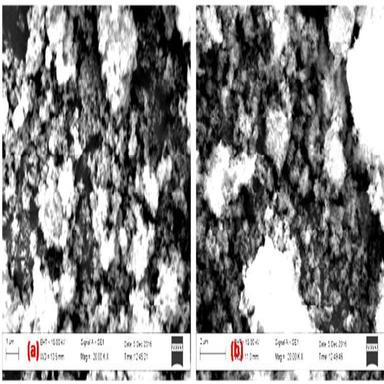
SEM images of (a) pure HAp; (b) doped HAp powder.